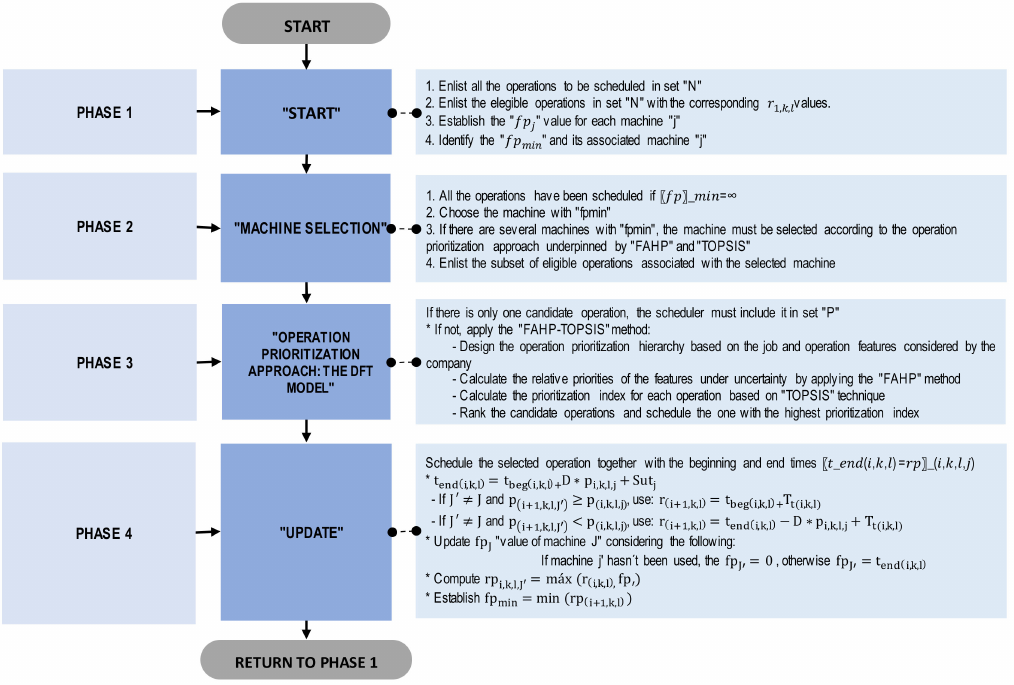
Figure 4. The proposed DFT approach for solving the